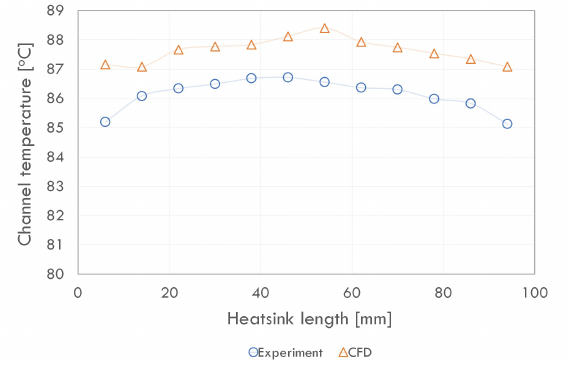
Figure 6. Dependence of average temperature of channels on their location [59].